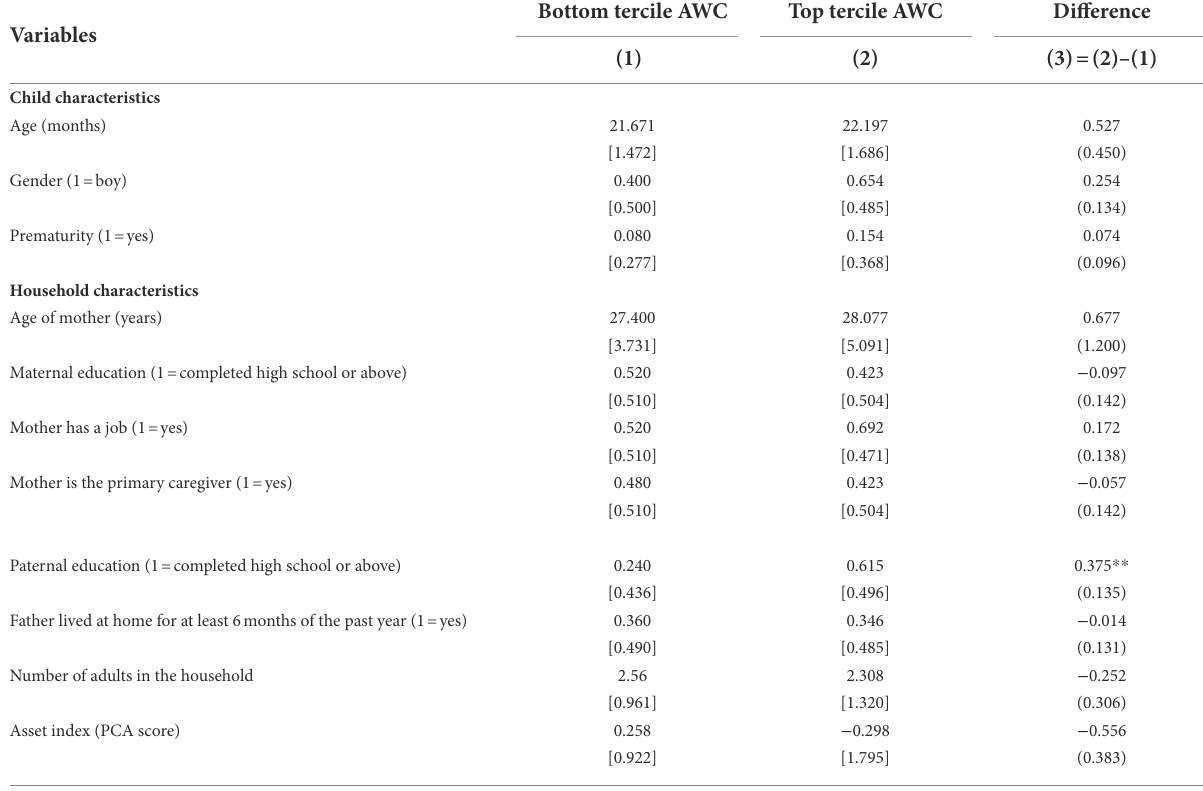
TABLE 2 Differences in demographic characteristics between top and bottom terciles of Adult Word Count